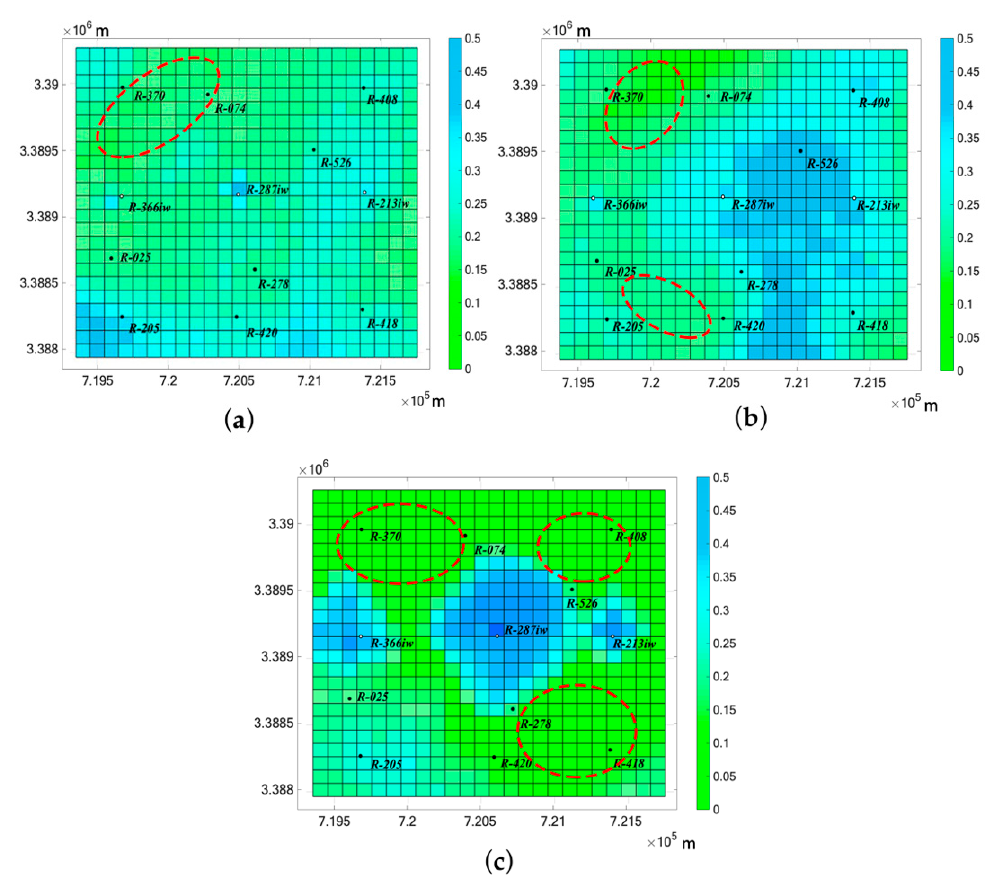
Figure 13. Remaining oil distribution in different layers at 48 th month of prediction (148 th month in whole time sequence): ( a ) Water saturation distribution in 12 th layer; ( b ) Water saturation distribution in 14 th layer; ( c ) Water saturation distribution in 27 th layer.